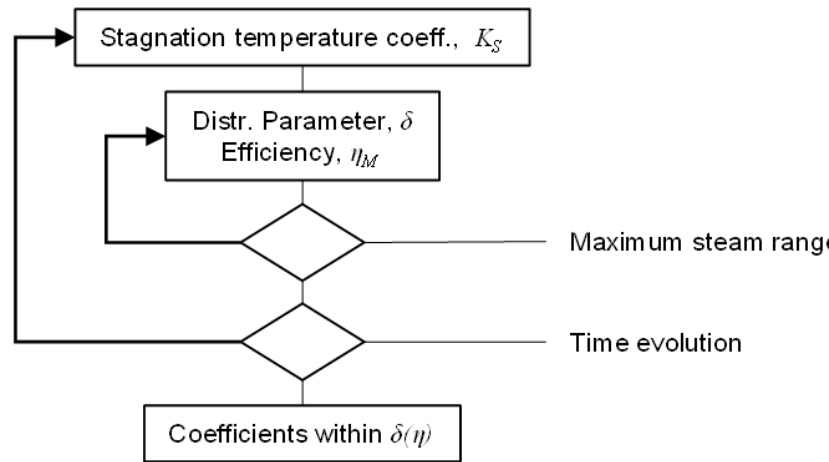
Figure 9. Procedure to determine model parameters. An initial value for the parameter, K S , for the effective stagnation temperature in Equation (2), was chosen. The distribution parameter, δ , was varied until the measured and simulated steam ranges matched. The corresponding efficiency of the meander region, η M , was stored for curve fitting. The time evolutions of the measured and simulated steam ranges were compared. If the gradients of the simulated steam range, which depend on the efficiency, were too small, the value of the parameter, K S , was increased and vice versa. This procedure was repeated until the steam ranges and the time evolutions matched. Finally, the parameters of the distribution function, Equation (49), were determined, based on the final values ( ) M .